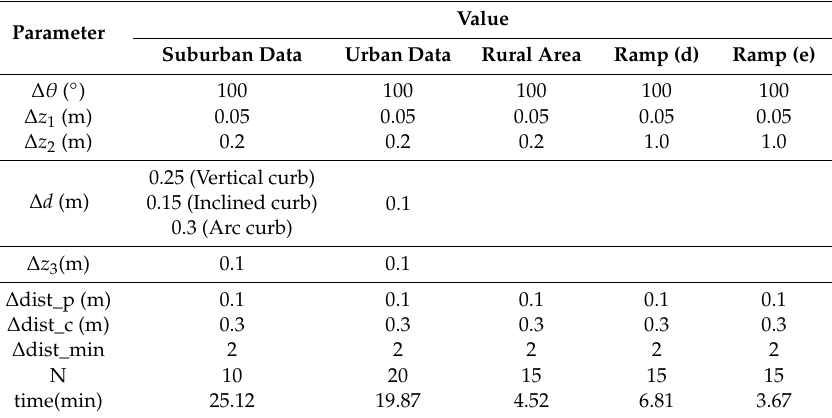
Table 1. Parameters used for calculation by the proposed